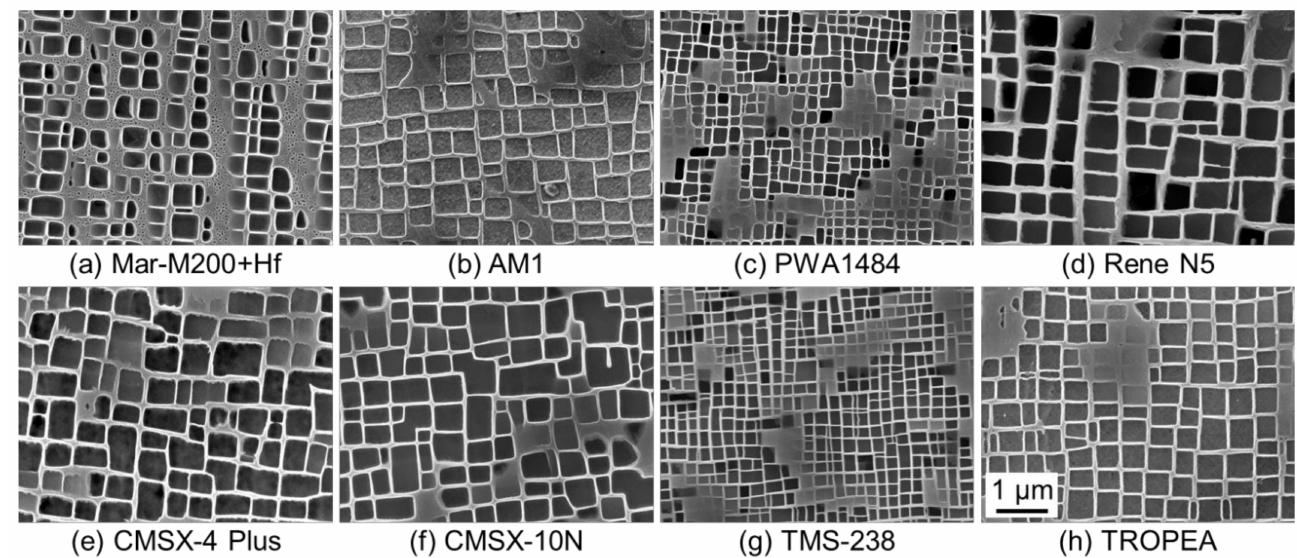
Figure 1. Microstructures of SX superalloys after heat treatments. ( a ) Mar-M200+Hf, ( b ) AM1, ( c ) PWA1484, ( d ) Rene N5, ( e ) CMSX-4 Plus, ( f ) CMSX-10N, ( g ) TMS-238, ( h )